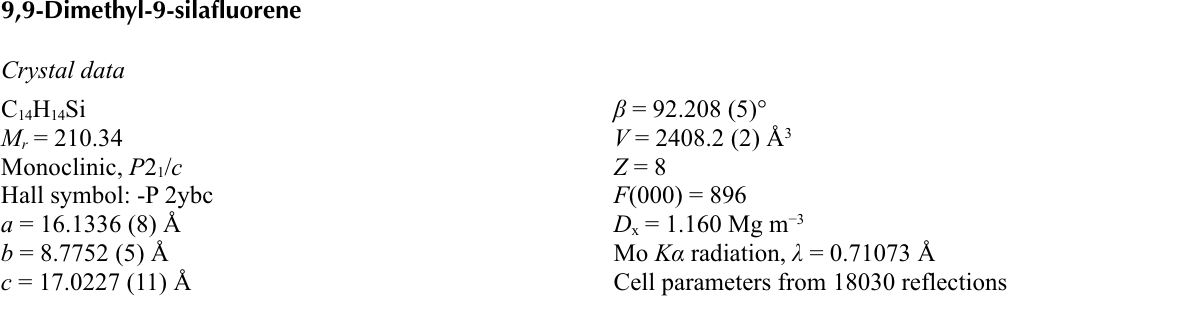
The formation of the title